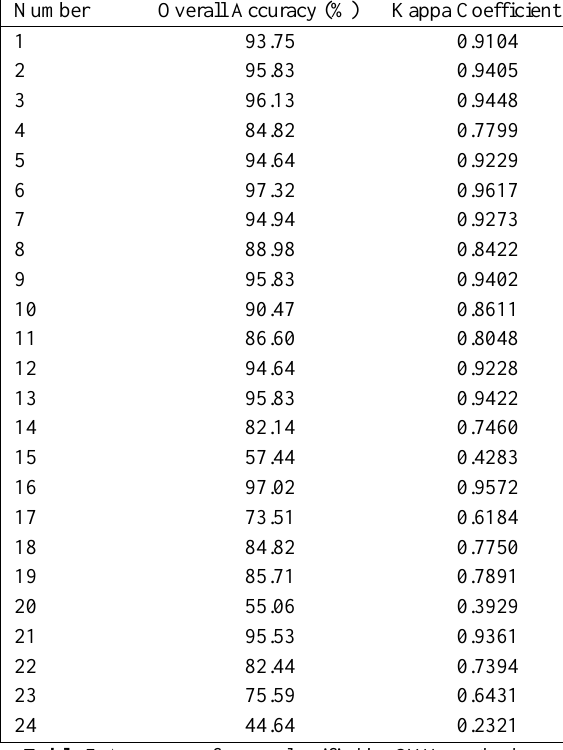
Table 5 . Accuracy of maps classified by SVM method.